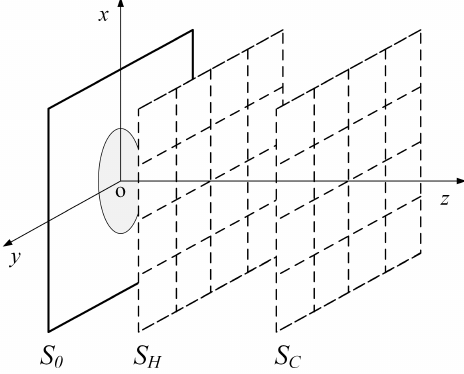
Figure 4. Scenarios of array distribution for simulating the planar baffled piston source. S 0 is the plane of planar baffled piston source, S H is the measuring plane, and S C is the calculation plane.